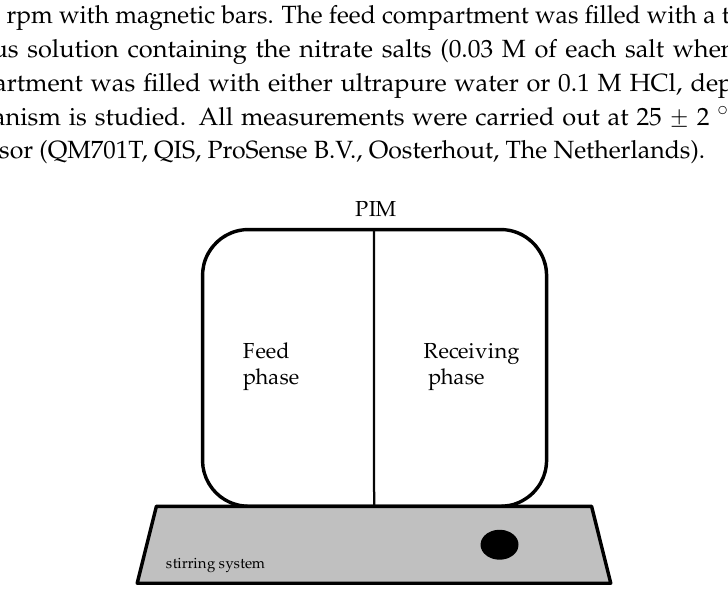
Figure 2. Scheme of the diffusion cell.